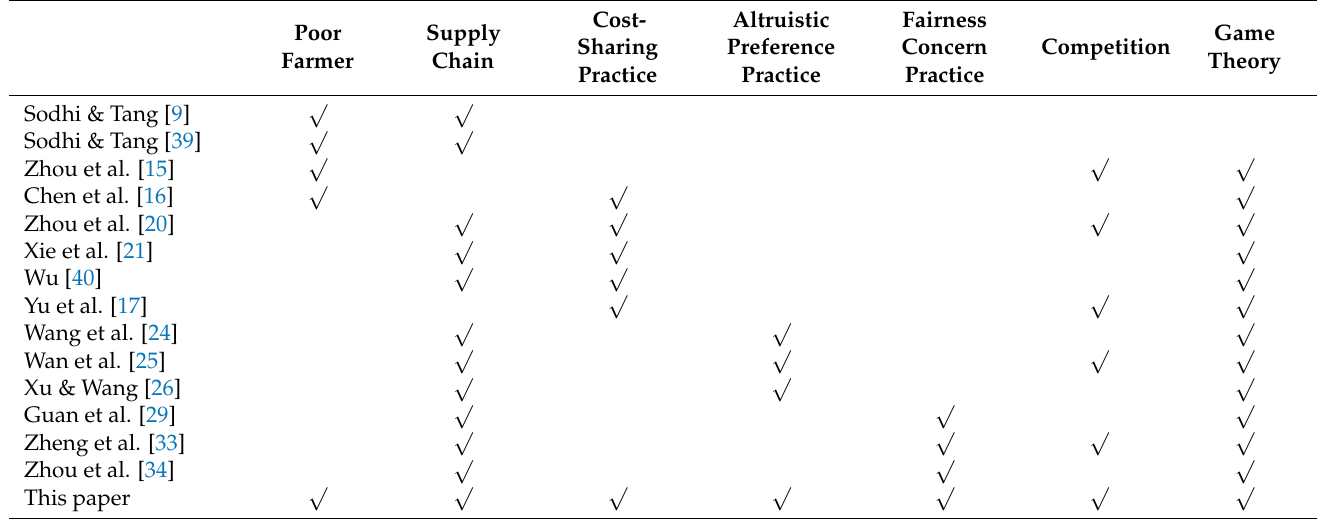
Table 1. Positioning of this